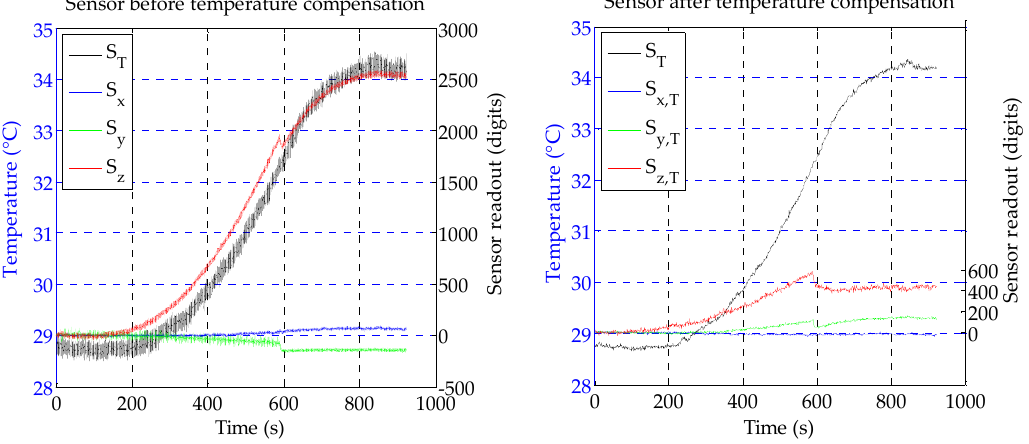
Figure 5. A comparison between the sensor’s readout before and after temperature compensation was applied. The right figure also shows the moving average of the sensor temperature, which was used for calibrating the sensor.